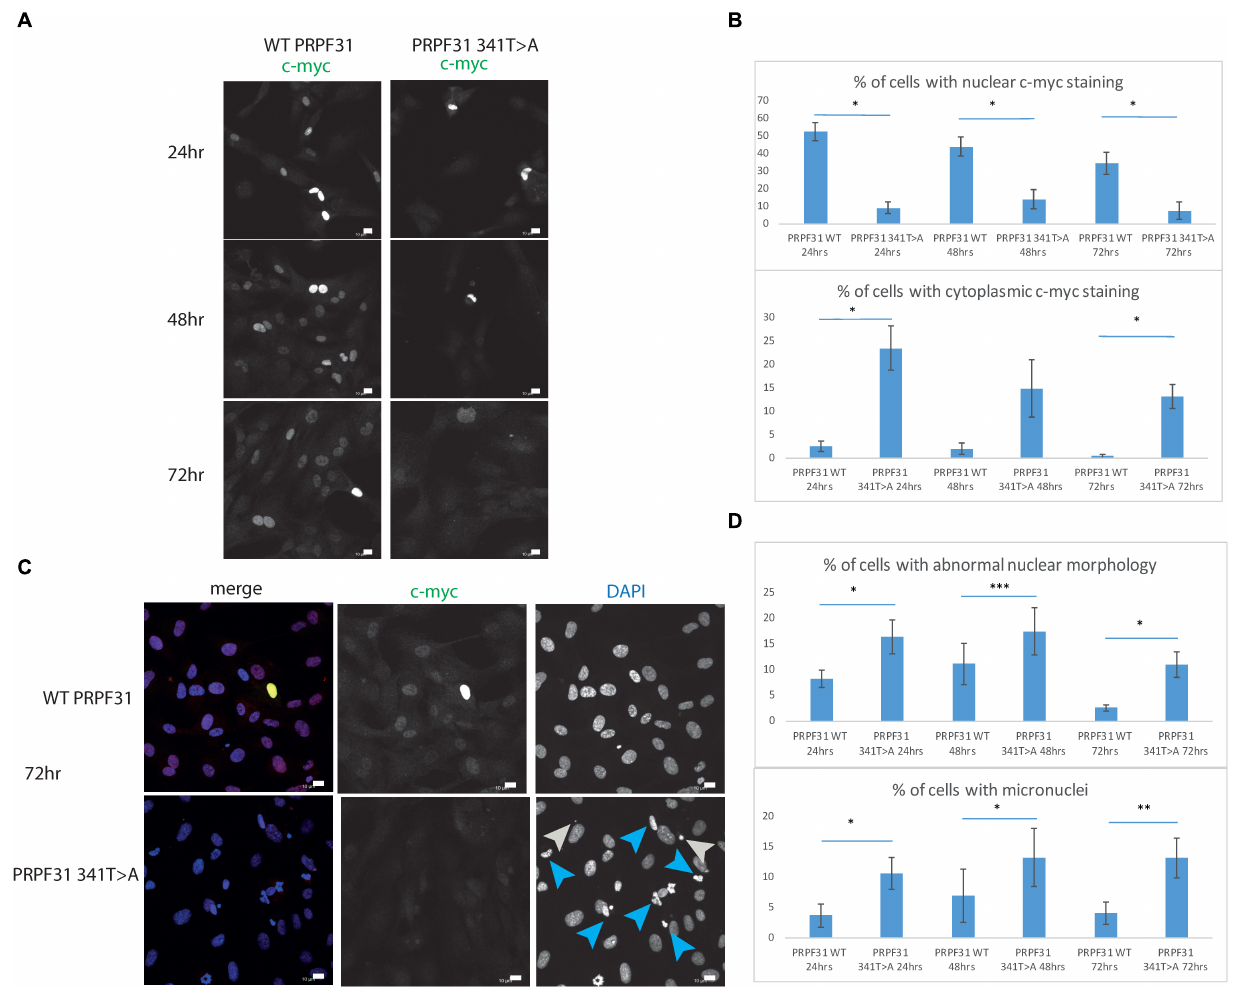
FIGURE 6 | In vitro characterization of PRPF31 c.341T > A Ile114Asn variant in hTERT-RPE1 cells. (A) Immunofluorescence confocal images of RPE1 cells transfected with c-myc-tagged wild-type or mutant PRPF31, showing expression and localization of PRPF31-cmyc over 24, 48, and 72 h. c-myc PRPF31 is evenly distributed throughout the nuclei of cells transfected with WT plasmid at each time point, but is concentrated in the nuclei of a few cells in RPE cells transfected with the mutant plasmid, with some cytoplasmic staining. Scale bars = 10 µ m. (B) Graphs and statistical significance of proportions of cells with nuclear and cytoplasmic c-myc staining after transfection with WT and 341T > A mutant PRPF31. ∗ p < 0.05, n = 4. Error bars show standard error of the mean. (C) At 72 h, nuclei staining shows many micronuclei (gray arrows) and nuclei with abnormal morphology (blue arrows) in the cells transfected with mutant PRPF31. Scale bars = 10 µ m. (D) Graphs and statistical significance of proportions of cells with abnormal nuclei morphology and micronuclei. ∗ p < 0.05, ∗∗ p < 0.01, ∗∗∗ p < 0.001, n =